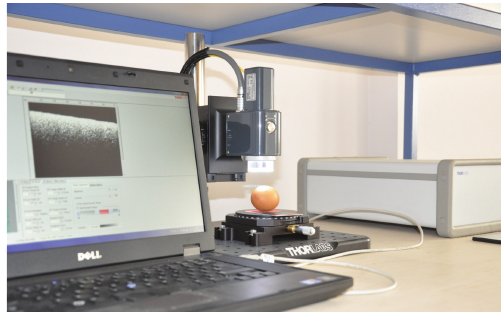
Figure 1: The experimental setup. The light generated by the super luminescence diode is sent through a cable and focused on the eggshell. The OCT scan can be seen on the laptops screen. The software allows for measuring desired lengths on the